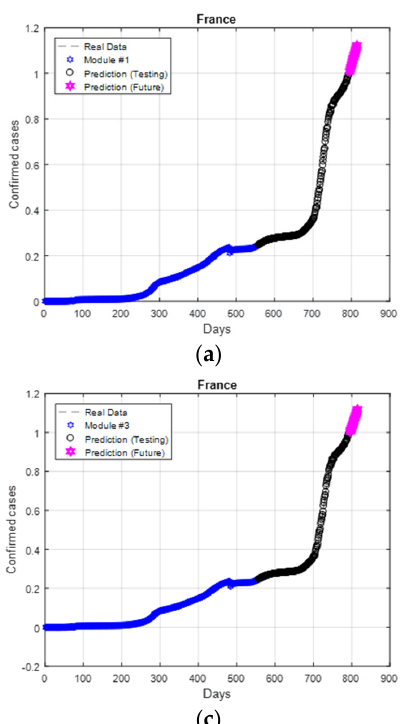
Table 10. First data period (testing prediction,